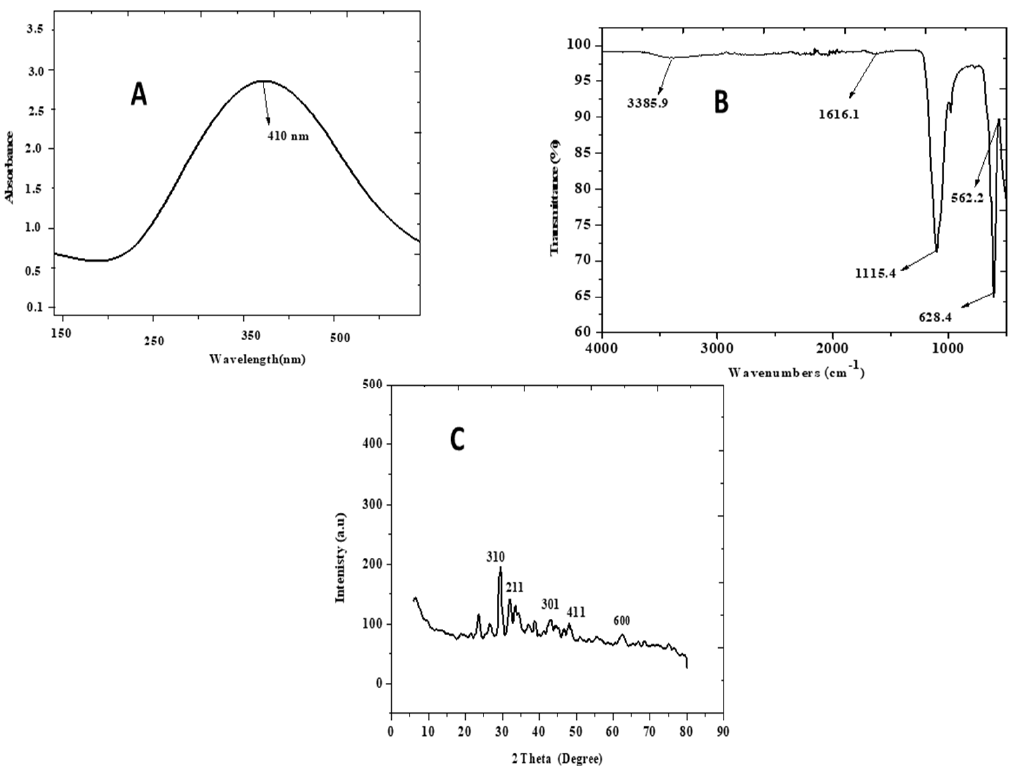
Figure 2. ( A ) UV–visible spectroscopy, ( B ) Fourier transform infrared (FTIR) spectroscopy, and ( C ) XRD pattern for the green synthesized MnO 2 NPs .